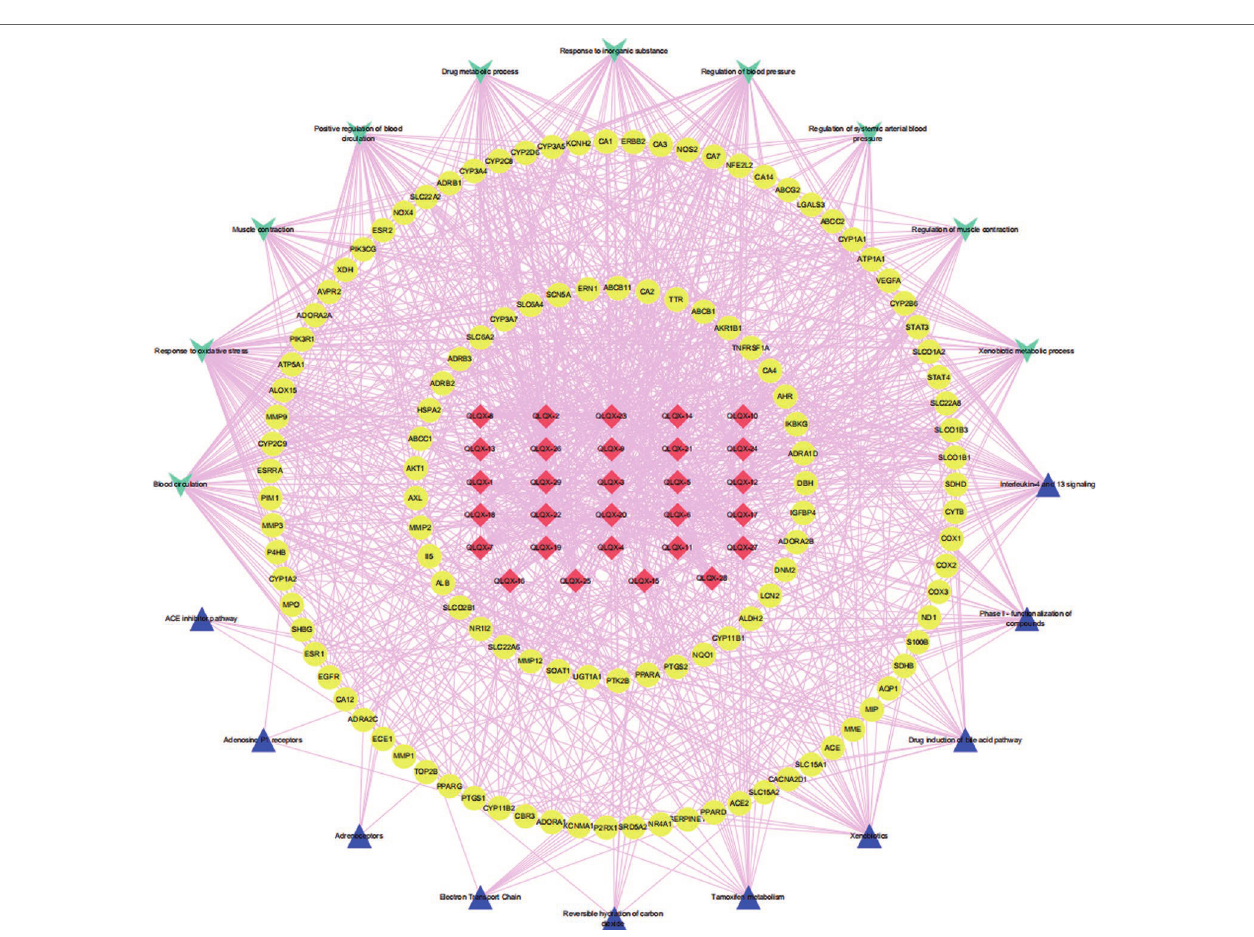
FIGURE 5 | The component-target-pathway/biological process network. The red diamond nodes represent the 29 active components in QLQX, the yellow ellipse nodes represent 120 putative targets associated with QLQX in the treatment of CHF, the wathet V nodes represent top ten biological processes and the mazarine triangle nodes represent top ten pathways related the 20